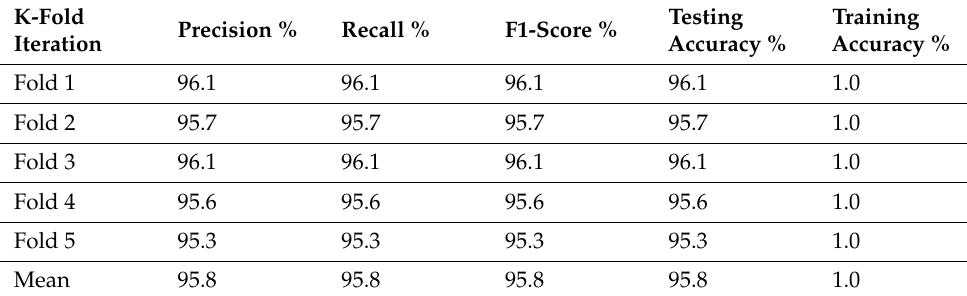
Table 4. The results of the RF classifier using five-fold cross-validation. K-Fold